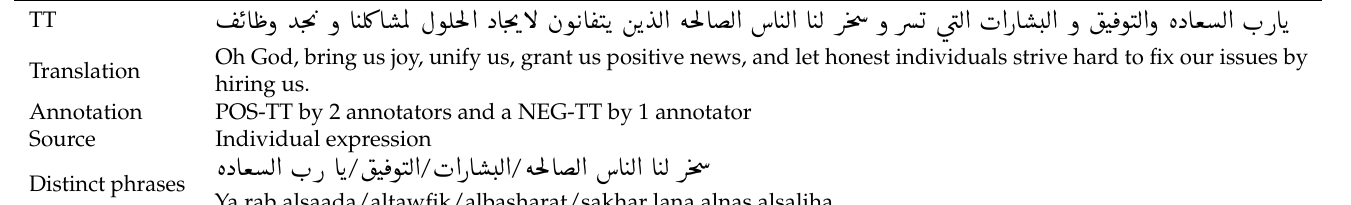
Table 9. A POS intention supplication.